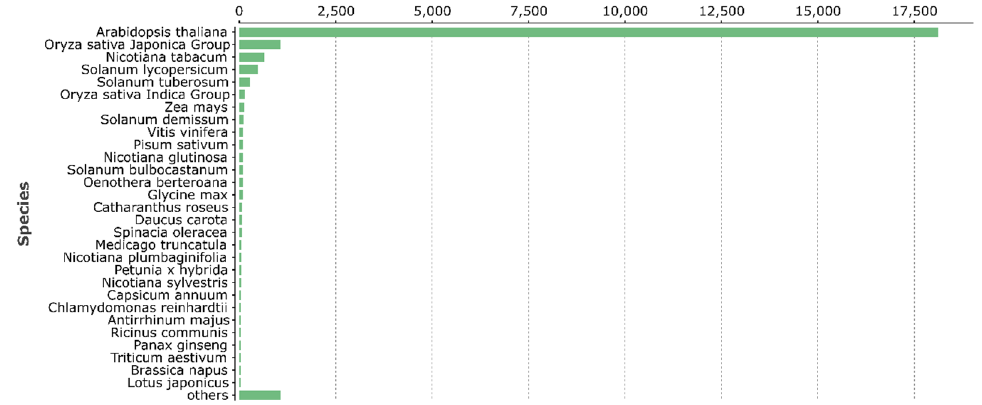
Figure 2. Top species distribution of annotated unigenes for tree tomato accessions A21 and A23. GO-based functional classification for A21 and A23 transcriptomes assemblies re- trieved a total of 196,800 GO terms for A21 and 204,090 for A23 from 22,096 and 23,095 transcripts, respectively (Table 2). The largest number of GO terms (75.2%) was annotated in sequences with a length between 100 and 500 bp (Figure 3).